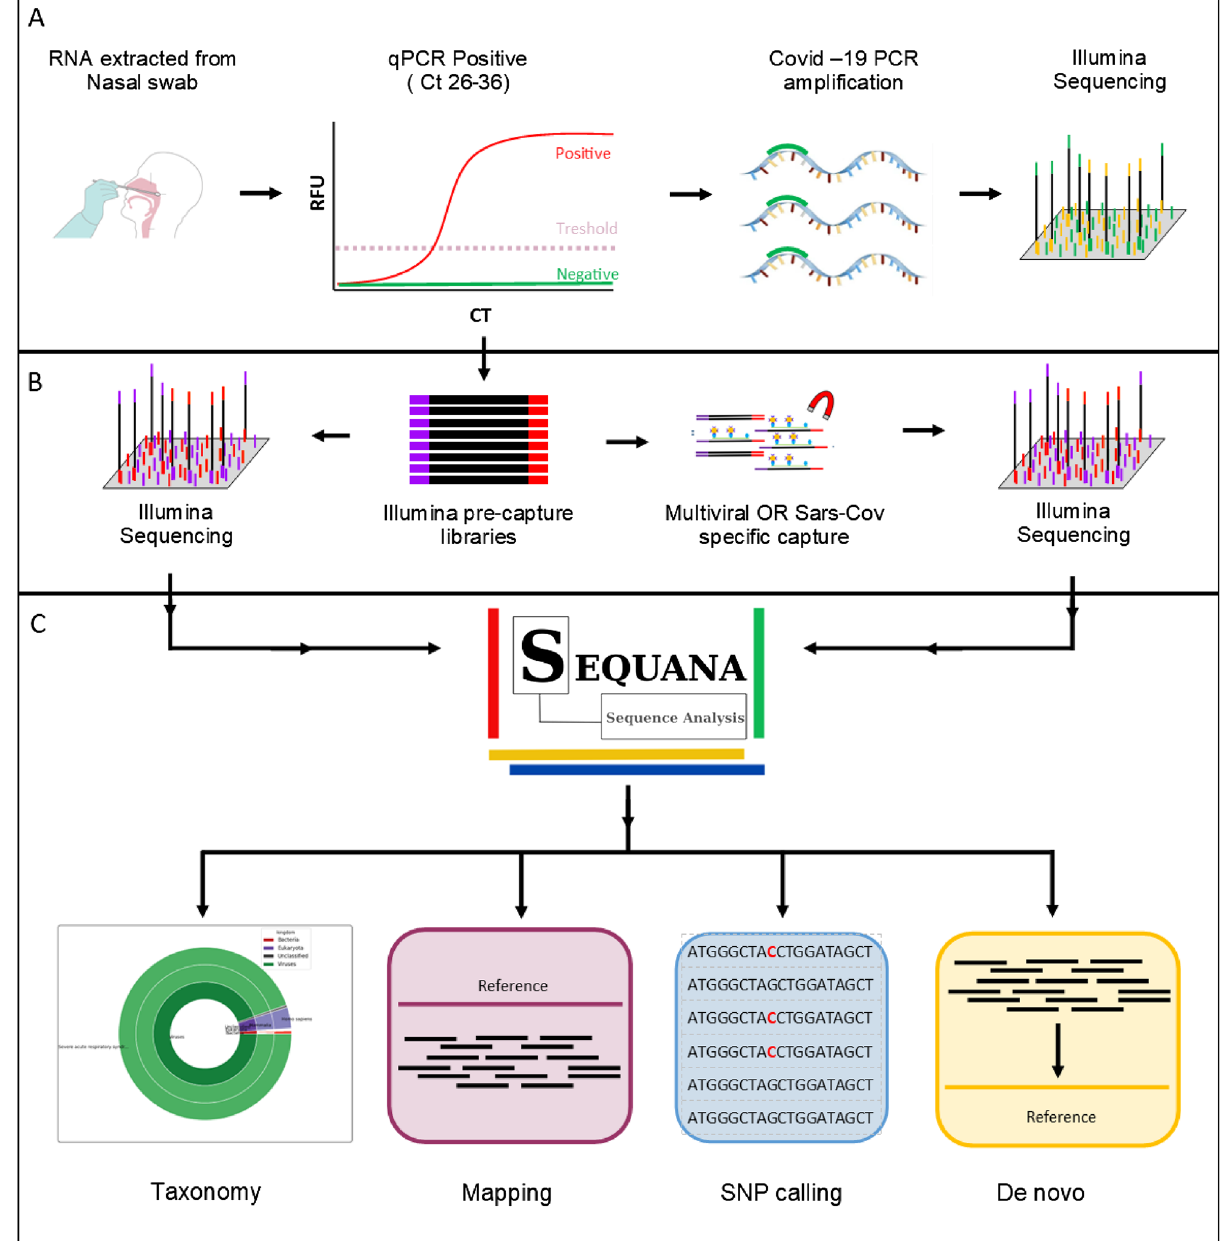
Figure 2. Overview of the study design: ( A ) RNA extraction from 20 samples collected from nasal swabs of patients with symptoms of COVID 19 was performed. After confirmation of the diagnosis by RT-qPCR, the viral genome of SARS-CoV-2 was amplified by PCR. ( B ) From the same RNA extraction, cDNA synthesis was performed using random hexamers. Library preparation was performed using the Nextera Flex Enrichment Library Preparation kit. All pre-capture libraries were sequenced using a Nextseq 500, in high-output mode. Samples were pooled for capture based on their viral CT and captured using five different capture probe pools: three targeting multiple viruses, including the SARS-CoV-2 genome, and two targeting the SARS-CoV-2 viral genome only. All pools were sequenced using a multi-Illumina platform approach. ( C ) All bioinformatics analyses were performed using NGS pipelines available within the Sequana project 13